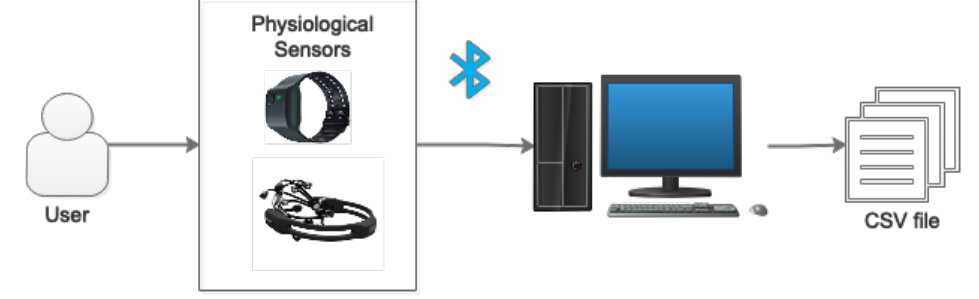
Figure 1. Classic model for acquisition of physiological